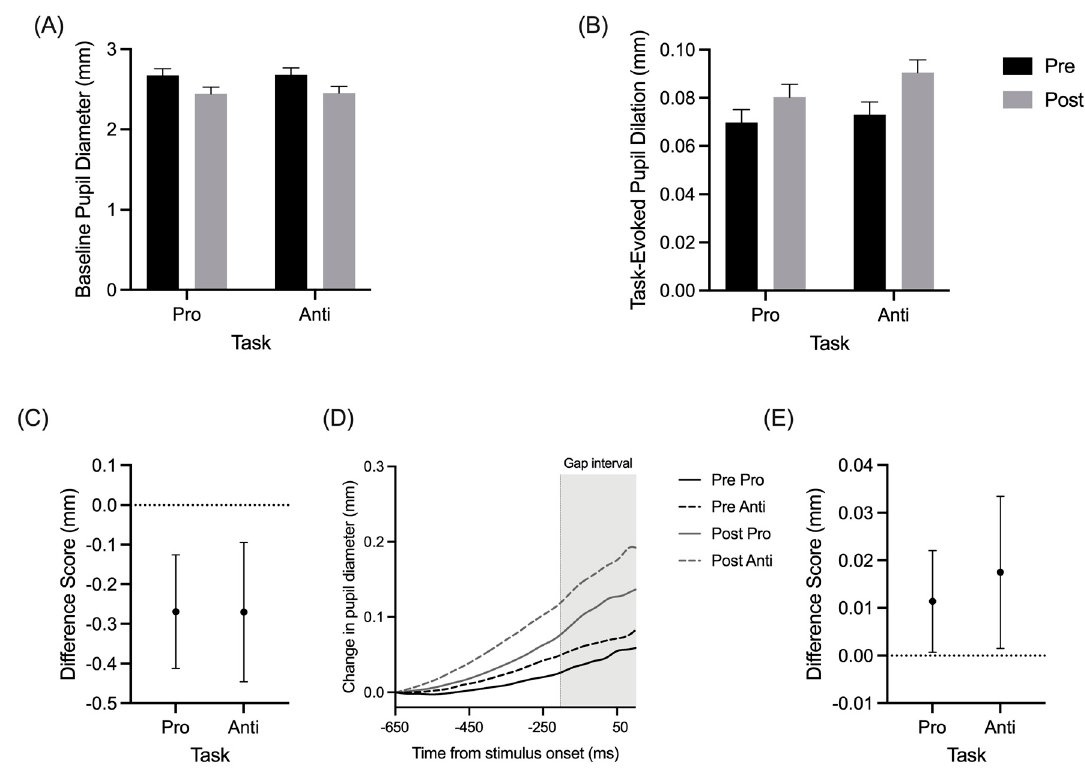
Figure 3. Group mean absolute pupil diameter ( A ) and task-evoked pupil dilation ( B ) for pro- and anti-saccades at pre- and postexercise assessments. Group mean difference scores (postexercise minus pre-exercise) for pupil diameter ( C ) and task-evoked pupil dilation ( E ). Baseline corrected pro- (solid lines) and antisaccade (dashed lines) pupil size changes by time traces for an exemplar participant during pre- (black lines) and postexercise (grey lines) assessments ( D ). Error bars represent 95% between-participant confidence intervals.